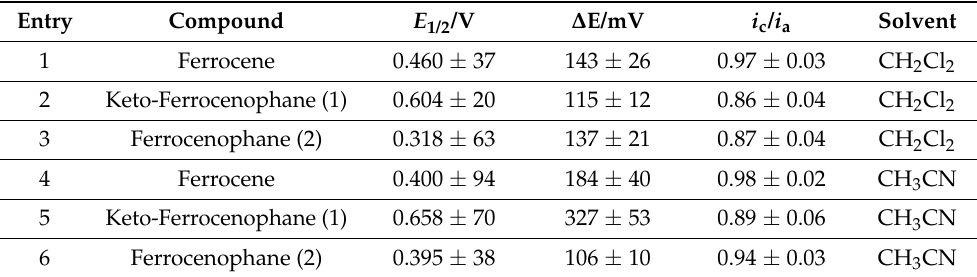
Table 2. Cyclic Voltammetry Values of Various